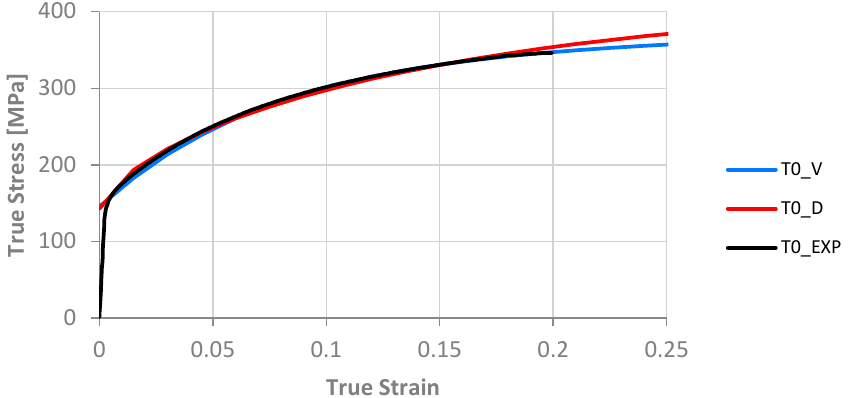
Figure 3. Fitting stress–strain curves for the DDR (D) and Voce-type (V) strain hardening rules.